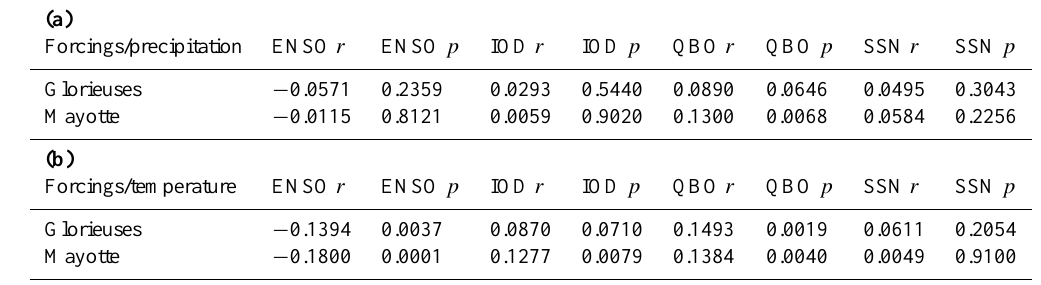
Table 1. Correlation coefficients ( r ) between the meteorological data time series ( a precipitation, b temperature) and the indices of the large scale oscillations (ENSO/SOI, IOD/DMI, QBO, SSN) and p value to test the hypothesis of no correlation.